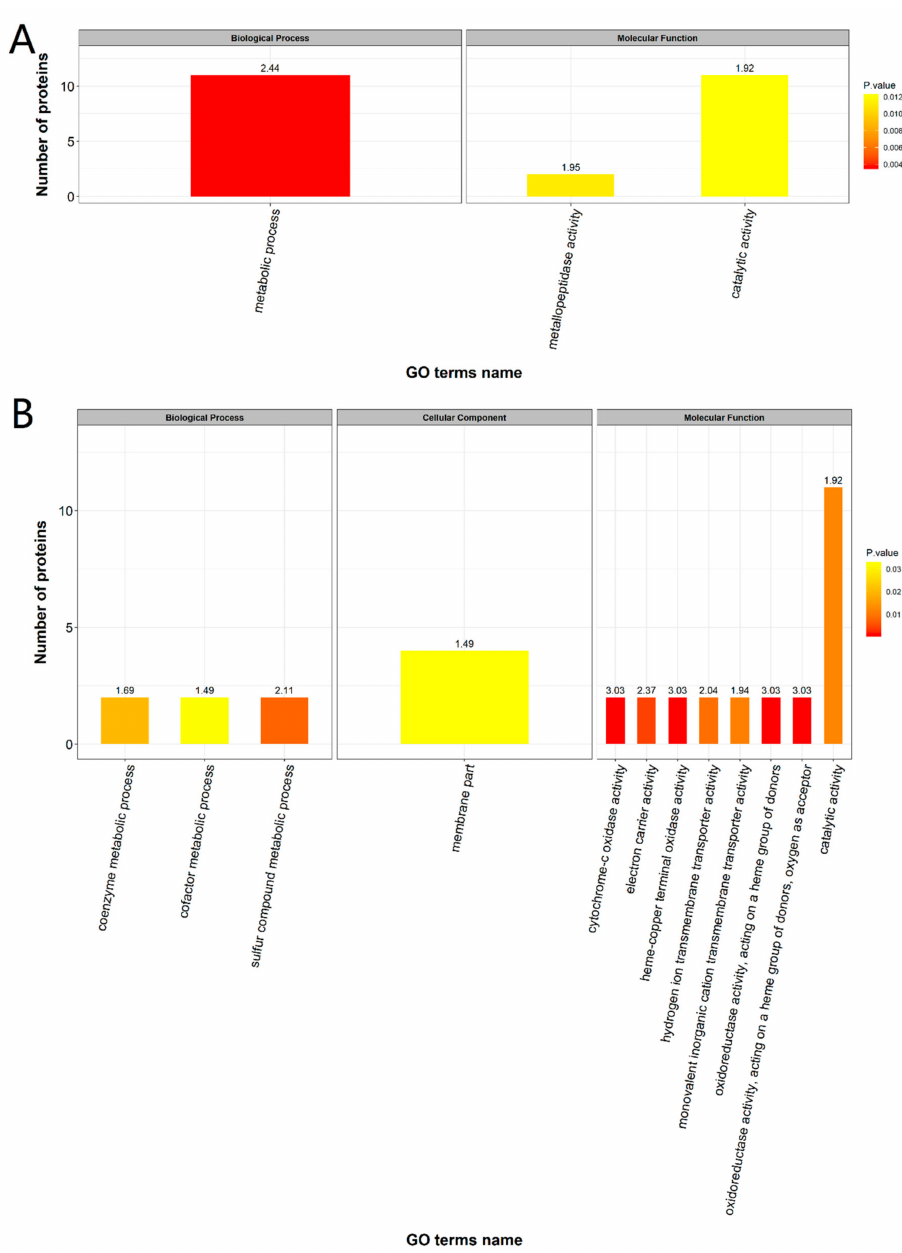
Figure 5. The functional enrichment of Gene ontology (GO) annotation of the up-regulated DEPs ( A ) and down-regulated DEPs ( B ). The number on the histogram represents the negative logarithmic transformation of the p -value obtained by the enrichment test (using Fisher’s exact